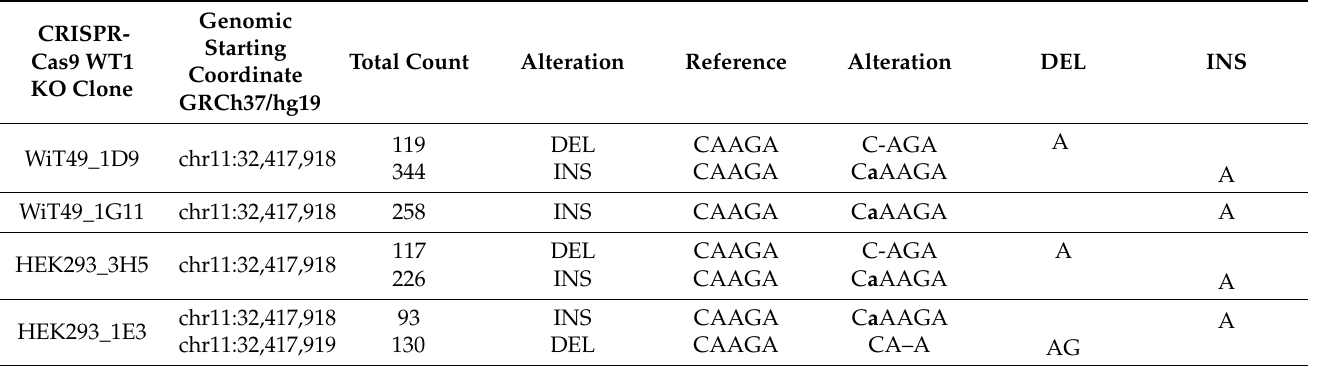
Table 1. Characterization of CRISPR-Cas9 mediated WT1 knockout clones by whole exome sequenc- ing. DEL—deletion mutation; INS—insertion